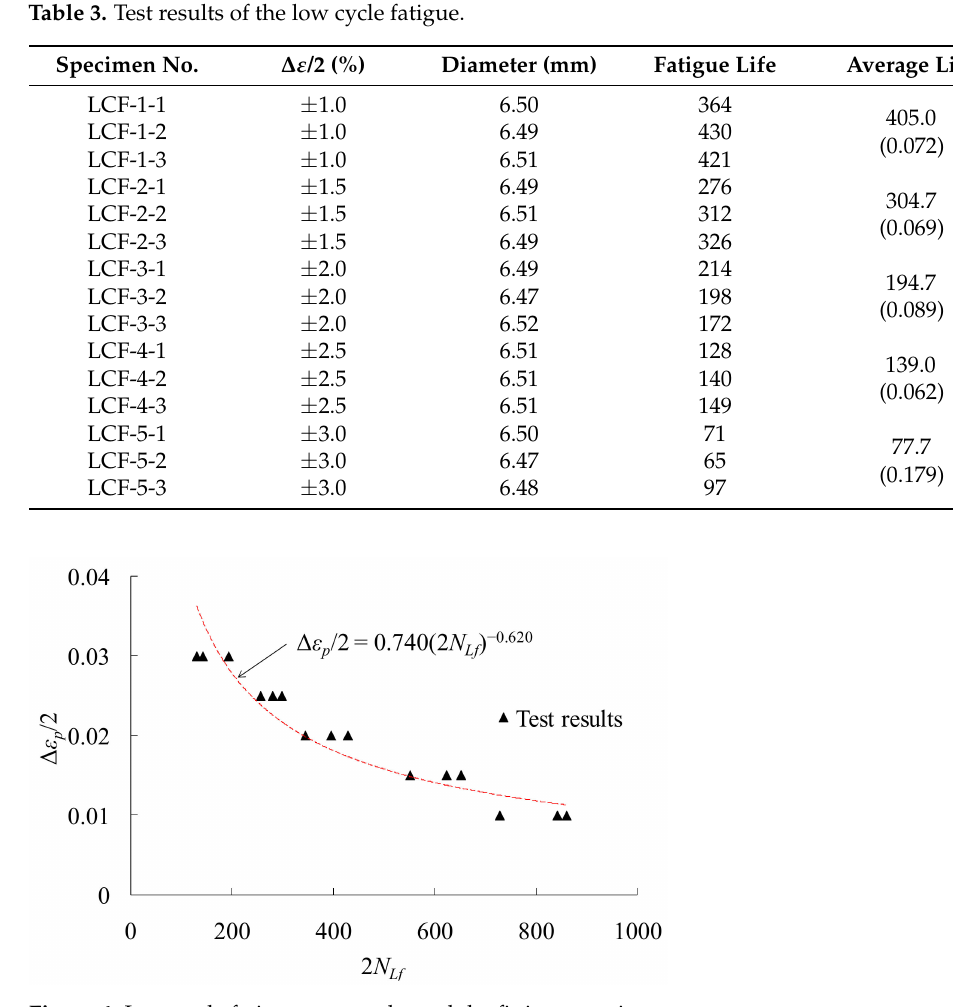
where C and k’ are parameters related to the material property. A cumulative damage index can be derived from Equations (3) and (4) [39]